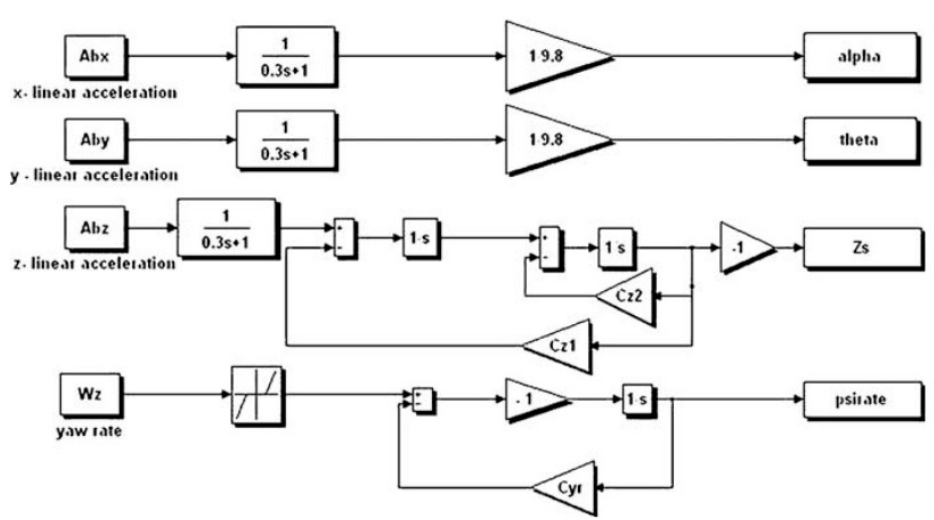
Figure 18. The semispherical motion base [64].